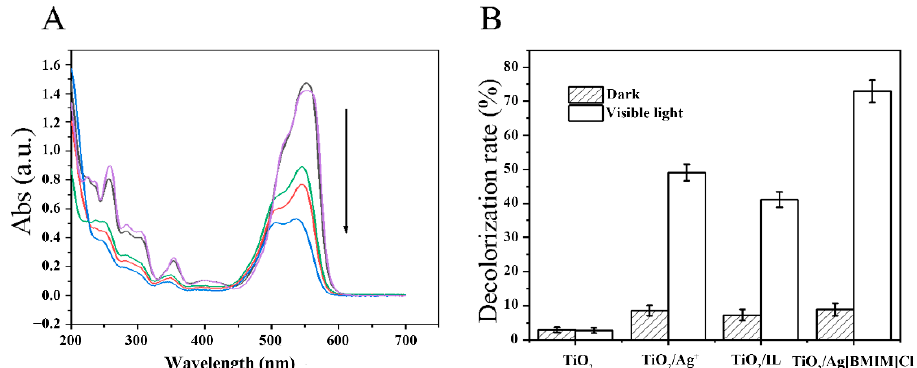
Figure 3. Ultraviolet spectra of Rhodamine B ( A ) and decolorization rates of different nanomaterials ( B ) in the preparation process of the TiO 2 /Ag[BMIM]Cl after photocatalytic degradation for 2 h. From top to bottom: Rhodamine B (15 mg/L), TiO 2 , TiO 2 /IL, TiO 2 /Ag + , TiO 2 /Ag[BMIM]Cl.